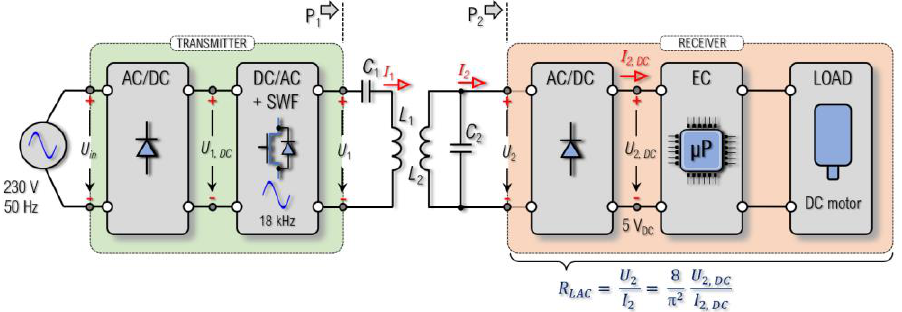
Figure 2. Block diagram of system topology; EO denotes any electronic circuits.